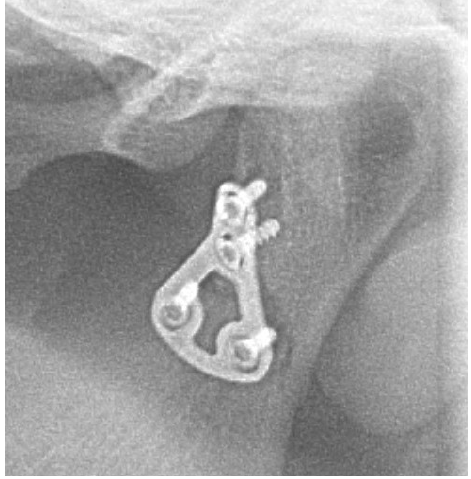
Figure 11. Patient A—An uncomplicated case—immediately after open reduction and internal fixation.